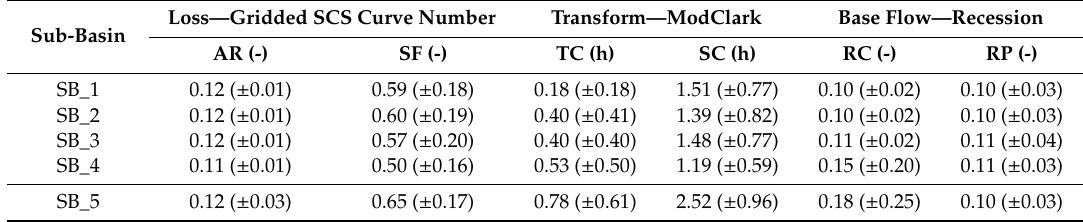
Table 5. Average optimum parameters for the HEC-HMS model for the Tsurumi River